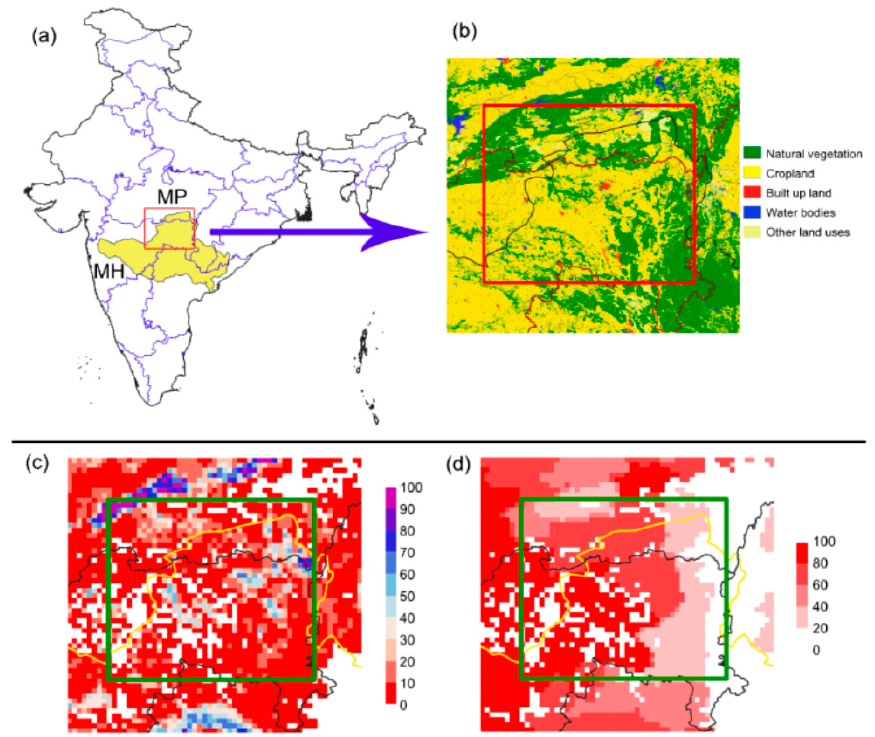
Figure 1. ( a ) The study region is marked by the red line. Administrative boundaries of Indian states (MH: Maharashtra; MP: Madhya Pradesh) and the Godavari river basin are shown. ( b ) Land use land cover data for 2005 are plotted using data from the Oak Ridge National Laboratory’s da- tabase [24]. ( c ) The irrigation equipped area as a percentage of total land area and ( d ) the percent- age of area irrigated by groundwater out of the total irrigation equipped area (plotted using data from Siebert et al. [25]).